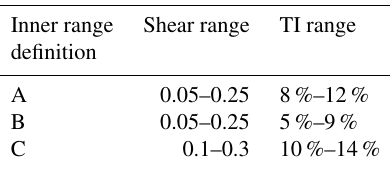
Table 2. Different inner range definitions. Inner range Shear